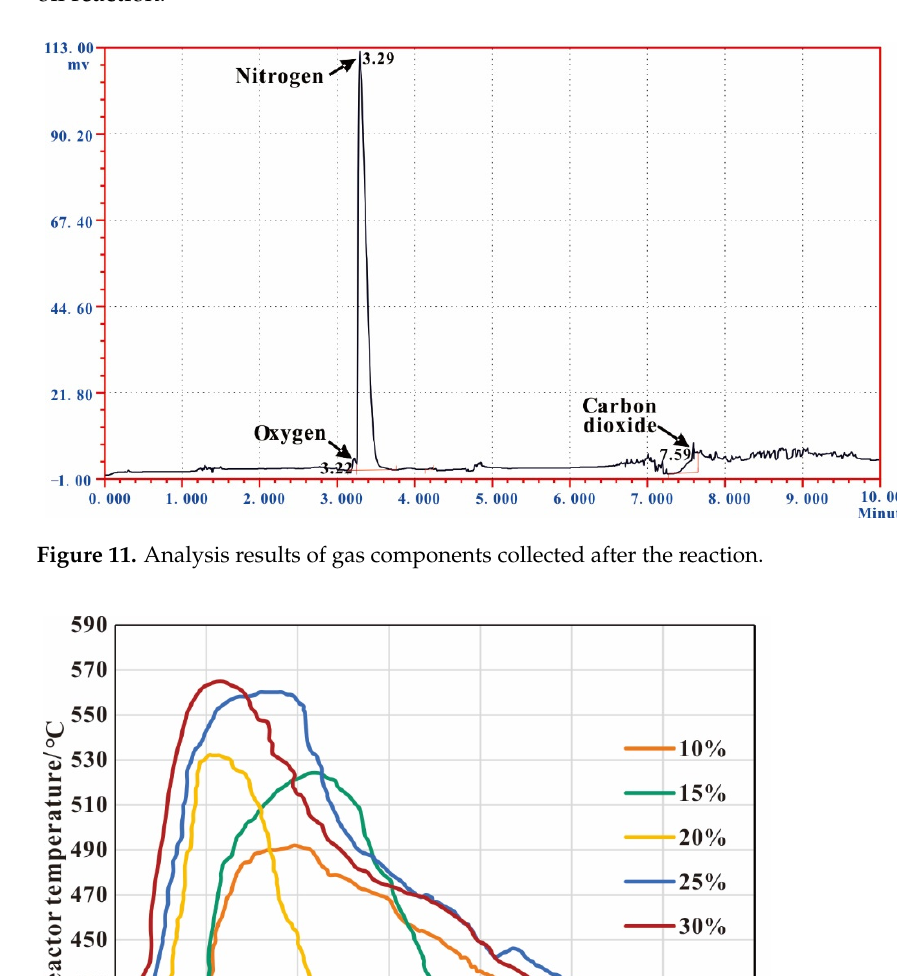
Figure 11. Analysis results of gas components collected after the reaction.